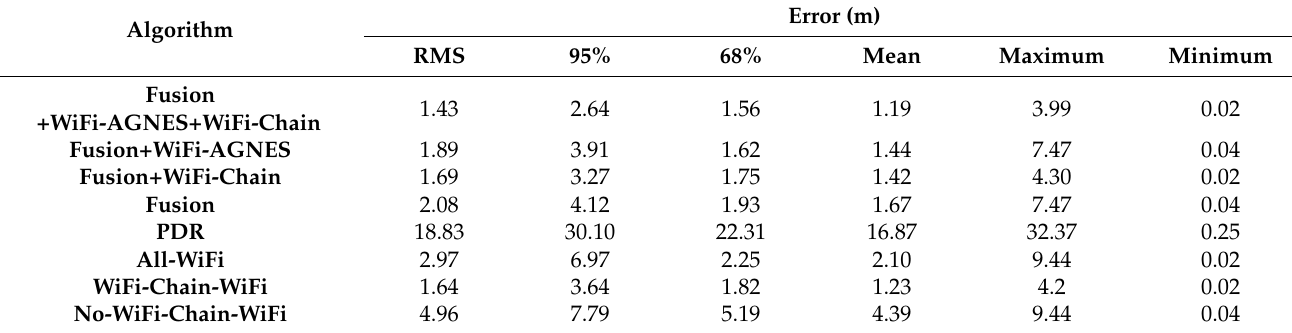
Figure 12. CDF of positioning error. ( a ) CDF of fusion, PDR and WiFi; ( b ) the performance of WiFi-Chain. Table 3. Various statistical results.